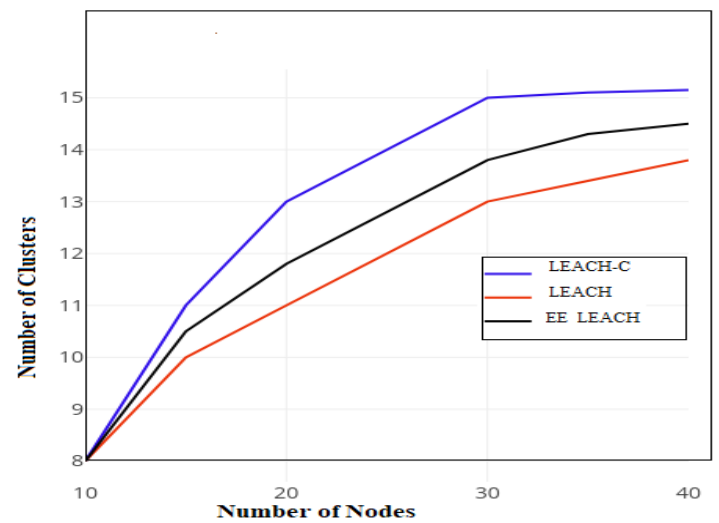
Figure 6. Number of clusters vs. number of nodes.